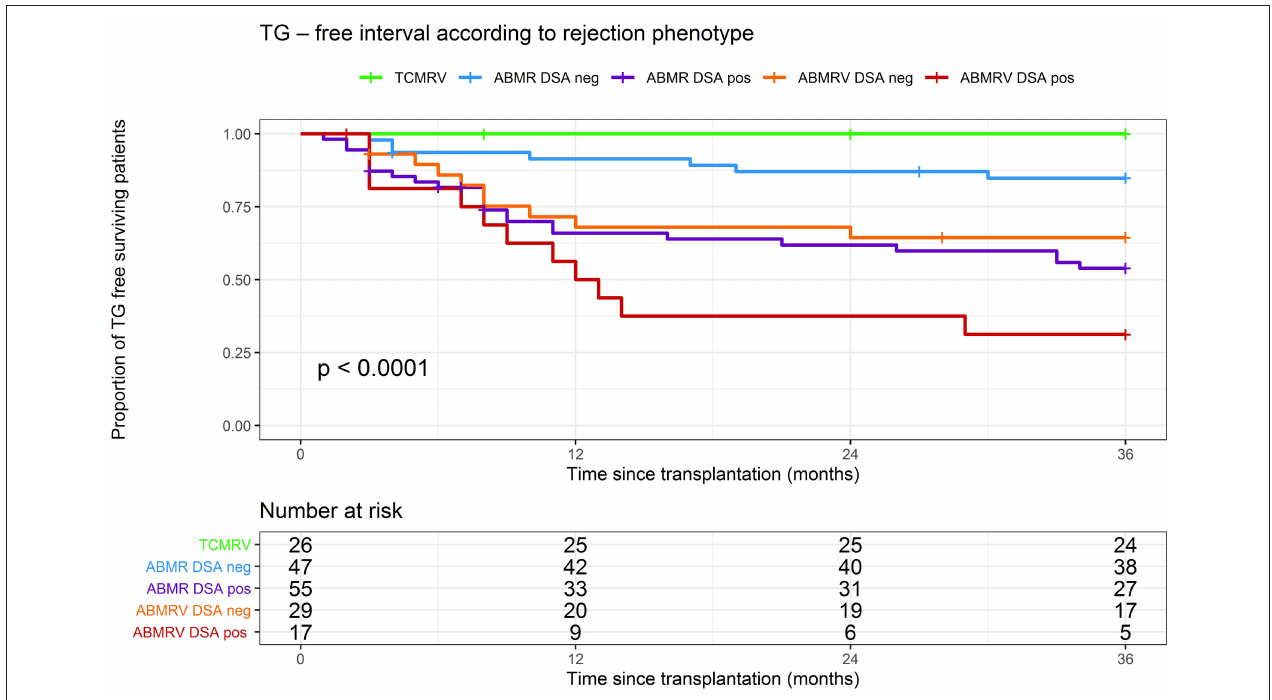
FIGURE 3 | Kaplan–Meier analysis of TG-free interval according to rejection phenotype.